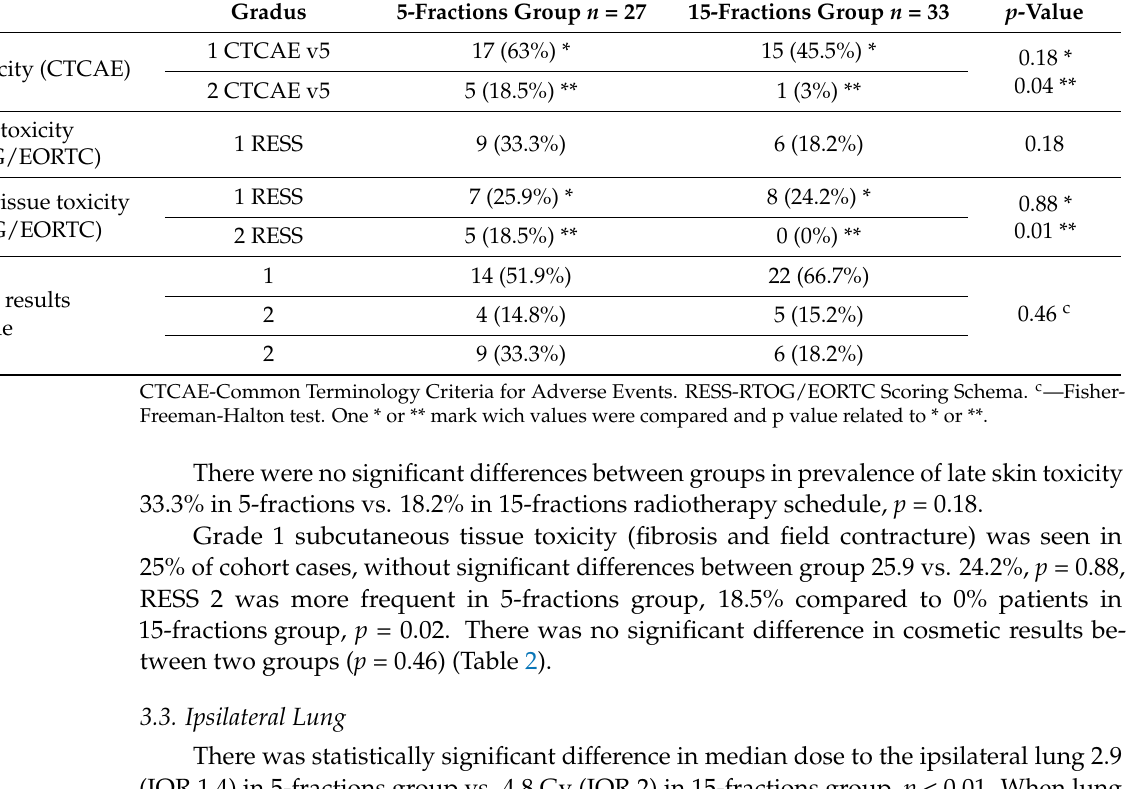
Table 2. Normal tissue effects between groups.